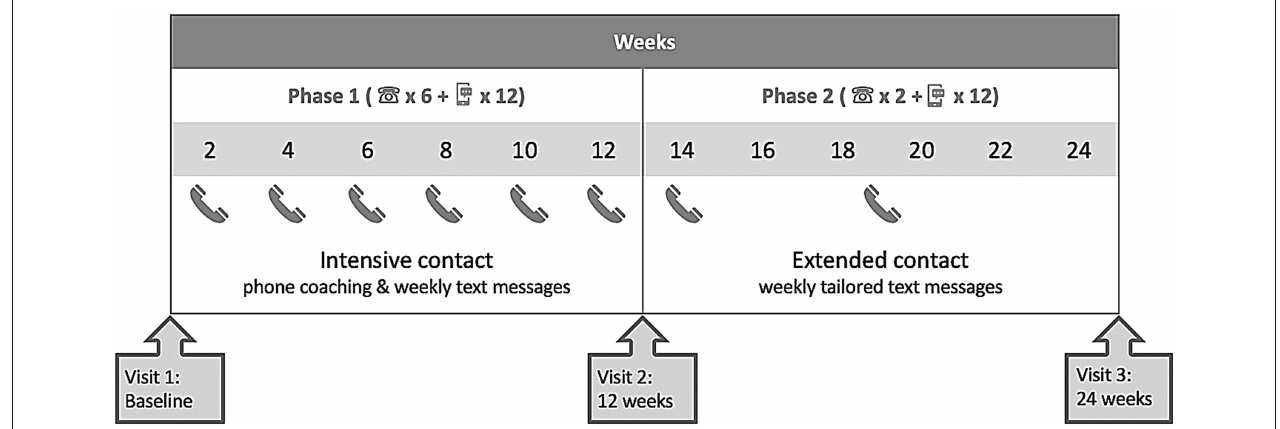
FIGURE 1 | Study scheme showing the intervention approach used in the ENTICE-CKD study.